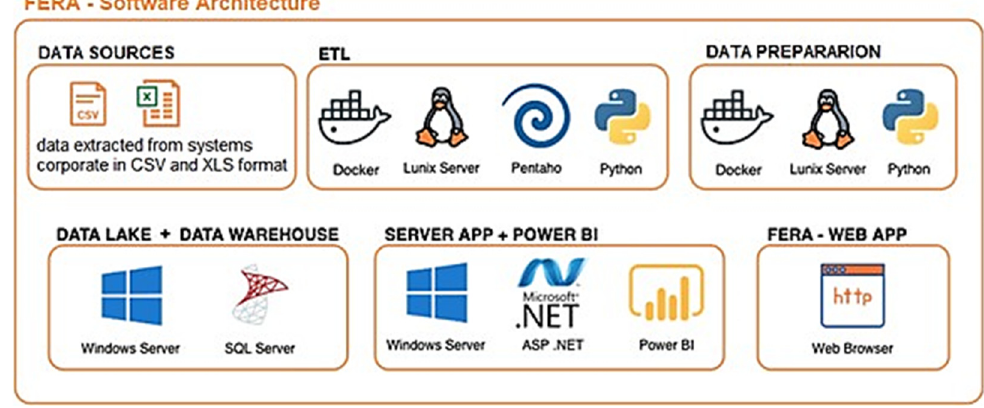
Figure 19. View of the software architecture used to execute the components of the FERA [authors].